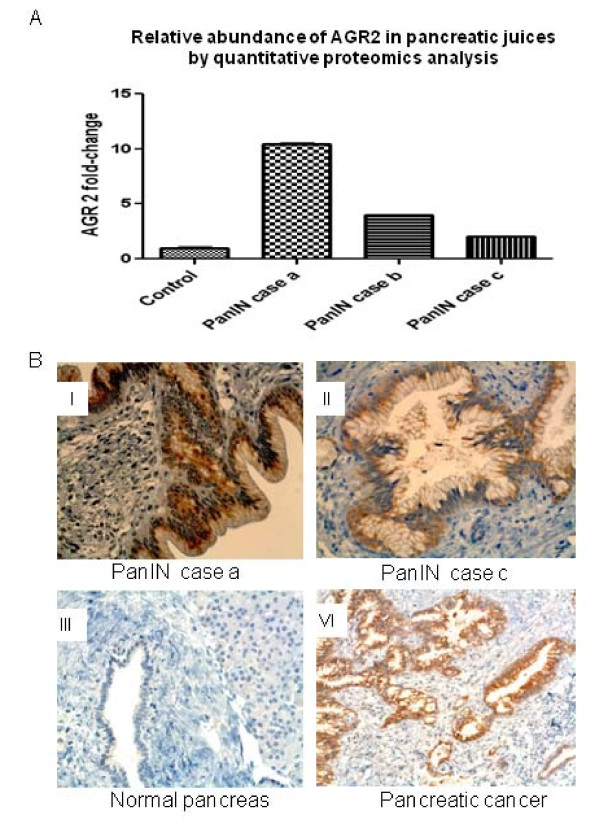
Elevation of AGR2. A. Fold-changes of AGR2 in pancreatic juice from patients with PanIN3 detected by quantitative proteomics analysis in comparison to controls. B. Detection of AGR2 by IHC in neoplastic pancreas ducts. Strong staining of AGR2 was detection in the neoplastic ducts of PanIN cases a and c (I and II), as well as the neoplastic region of pancreatic cancer (VI). AGR2 was not detected in the normal pancreas duct (III).